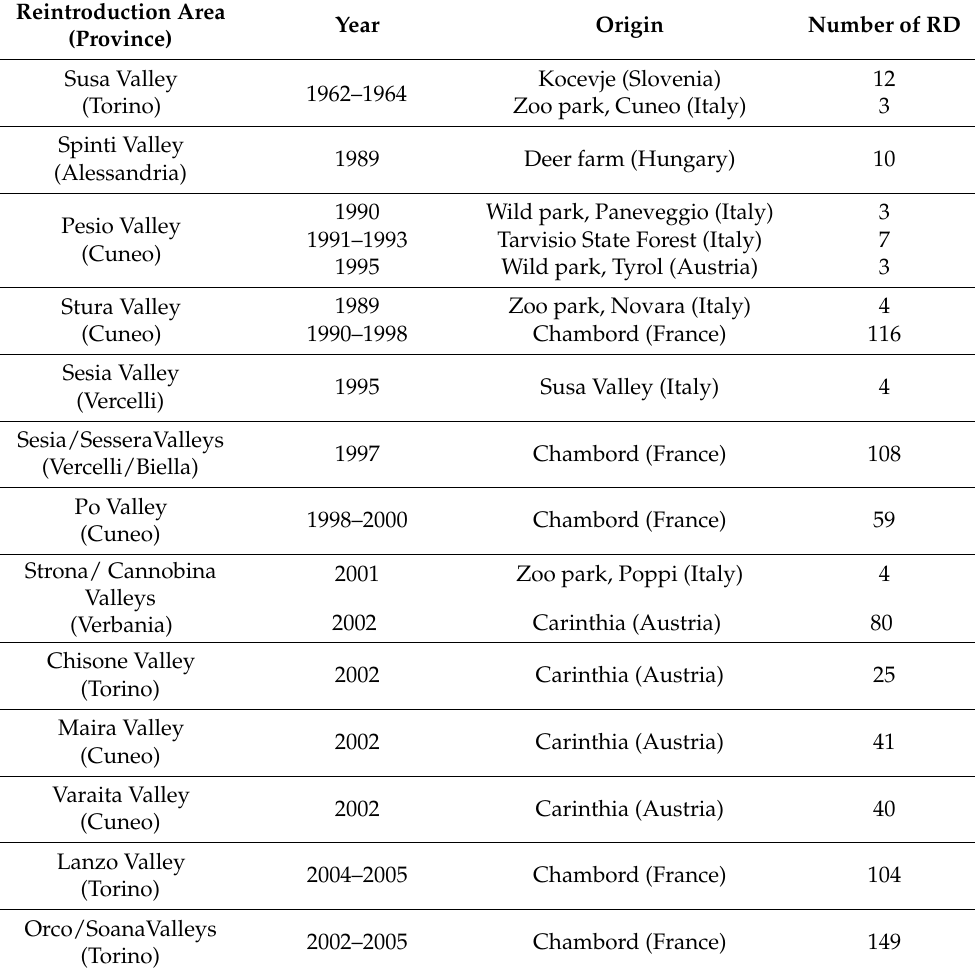
Table 1. Origin and number of red deer translocated to Piedmont between 1962 and